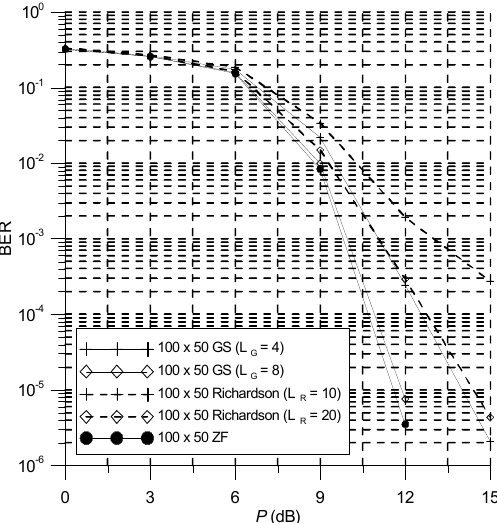
Figure 5. The bit error rate (BER) performances for GS pre-coding, Richardson pre-coding, and ZF pre-coding in 100 × 50 system when an initial solution is s